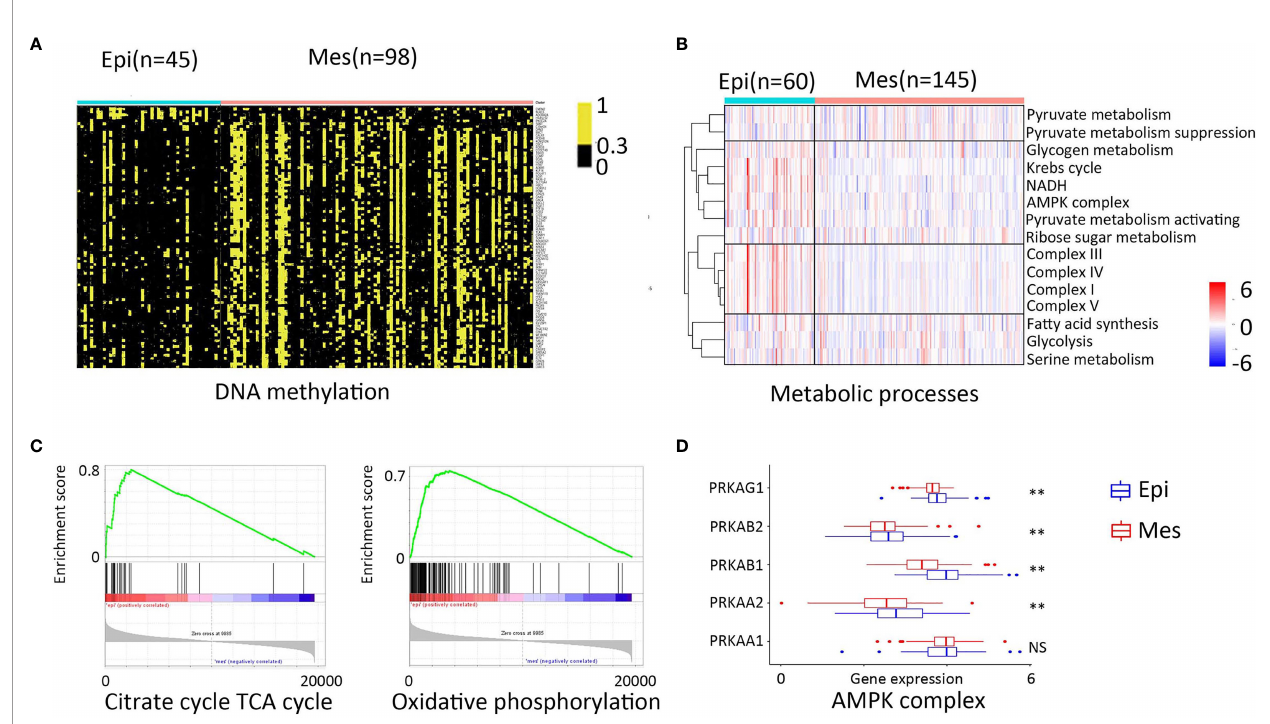
FIGURE 5 | Methylationand metabolism patterns. (A) Heatmaprepresentationof the clusteringof 89highlyvariableDNAmethylationprobes. Amethylation b -value R greater than0.3 wasconsideredhypermethylated. (B) Heatmap representationofthecomparisonofmRNA expressionsignatures for theselectedmetabolic processes betweenthe different EMTsubtypes. (C) GSEA plot ofcitrate cycleTCA cycleand oxidativephosphorylation. (D) AMPKcomplexgene expression(**, 0.001 < P< 0.01; ns, P>